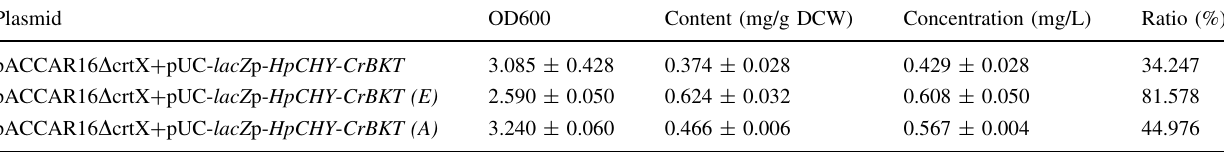
Each value is shown as mean ± standard deviation (n C